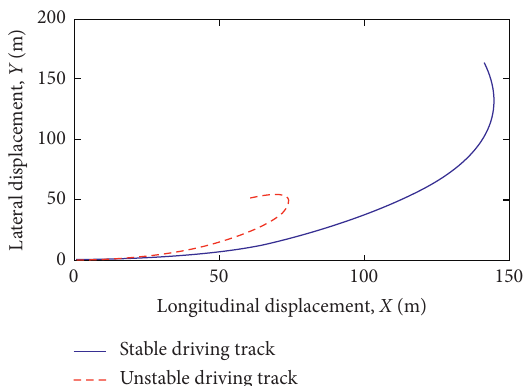
Figure 2: Comparison of vehicle driving tracks on normal and slippery roads.